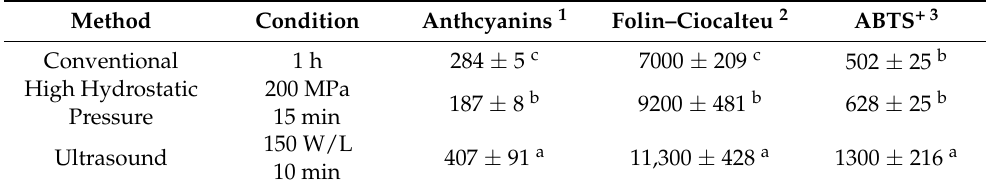
Table 3. Anthocyanins, Folin–Ciocalteu reducing capacity, ABTS+ from extracts obtained by conven- tional and non-conventional methods.